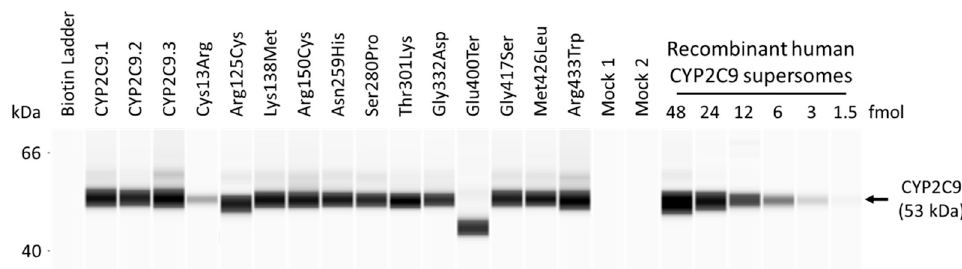
Figure 1. Representative western blots showing immunoreactive cytochrome P450 2C9 (CYP2C9) proteins. Average CYP2C9 levels were normalized according to total protein content. All assays and measurements were performed in triplicate using a single microsomal preparation. Recombinant human CYP2C9 supersomes were used to construct a standard curve through serial dilution (1.5–48 fmol) to quantify CYP2C9 total protein content. Ter represents amino acid termination. Mock 1 represents transfection with 10 µ g mock plasmid. Mock 2 represents transfection with 9.6 µ g mock plasmid, 0.2 µ g cytochrome P450 oxidoreductase (CPR) plasmid, and 0.2 µ g cytochrome b 5 plasmid. N.D. represents not determined. Table 2. The characterization of microsomes prepared from 293FT cells co-expressed with CYP2C9 variants, CPR, and cytochrome b 5 . Cytochrome b 5 Protein)